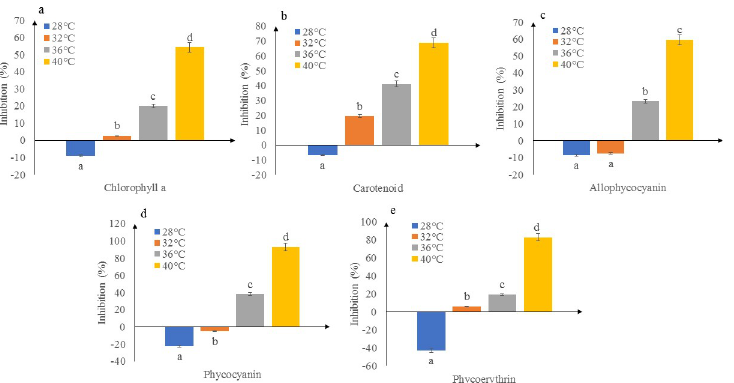
Fig 3. Percentage inhibition of pigment content of K . alvarezii incubated at different temperatures: a) chlorophyll- a , b) carotenoid, c) allophycocyanin, d) phycocyanin and e) phycoerythrin. Data shown are mean values and standard deviations ( n = 5). Different lowercase letters indicate significant differences ( p < 0.05) between different temperature treatments for each biological